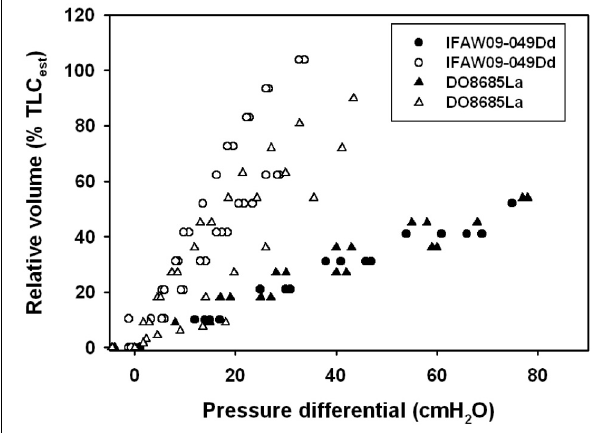
FIGURE 1 | Lung volume expressed as a percentage of estimated total lung capacity (TLC est , Kooyman, 1973; Fahlman et al., 2011) vs. trans-thoracic (whole animals, filled symbols) or trans-pulmonary (excised, open symbols) pressure in a common (Dd: Delphinus delphis ) and Atlantic white-sided dolphin (La: Lagenorhynchus acutus ). Measurements shown are during deflation of the